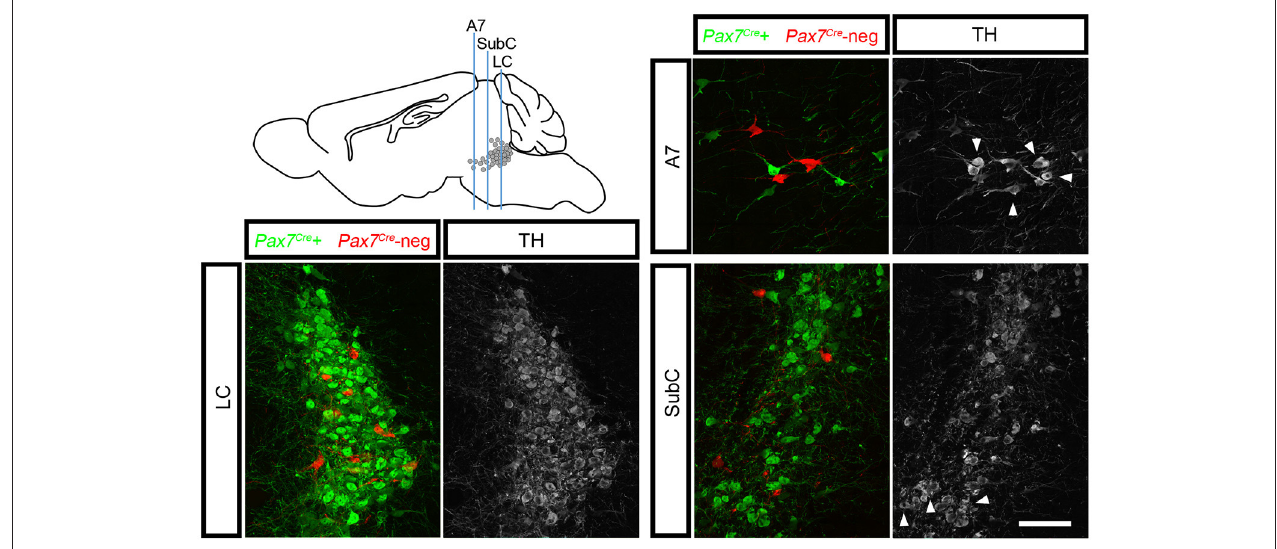
FIGURE 3 | Pax7 Cre -negative noradrenergic neurons are distributed throughout the LC complex. Sagittal schematic of the adult mouse brain shows approximate position of coronal sections from the brain of a 3-month old adult En1 Dre ; Dbh Flpo ; Pax7 Cre ; RC::RFLTG quadruple heterozygote. In the locus coeruleus (LC), subcoeruleus (SubC), and A7 nuclei, Pax7 Cre -negative noradrenergic neurons (tdTomato) are intermingled with Pax7 Cre -positive noradrenergic neurons (EGFP). Anti-tyrosine hydroxylase (TH) immunostaining (gray) confirms the noradrenergic identify of labeled neurons. Noradrenergic neurons in SubC and A7 that originate outside En1 Dre -defined r0 and r1 are TH-positive but are not labeled by the indicator allele (arrowheads). Scale bar: 100 µ m.